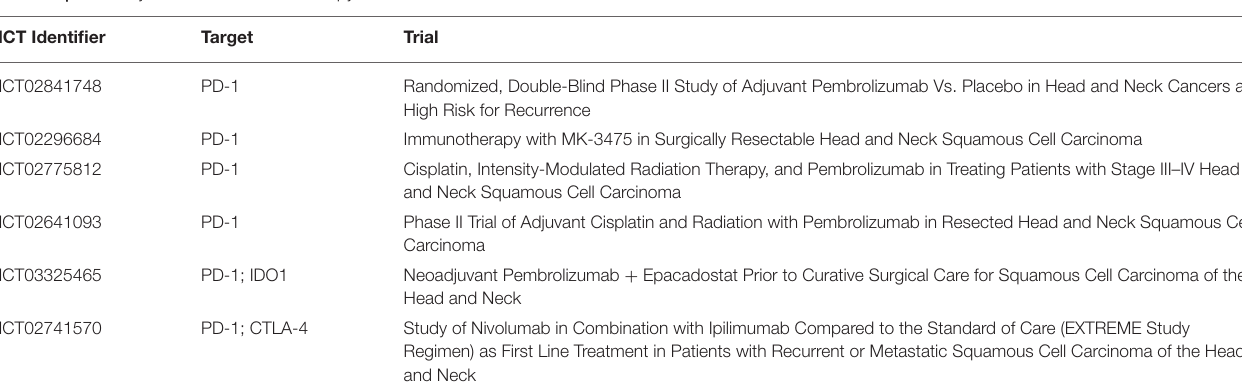
TABLE 2 | Summary of selected immunotherapy